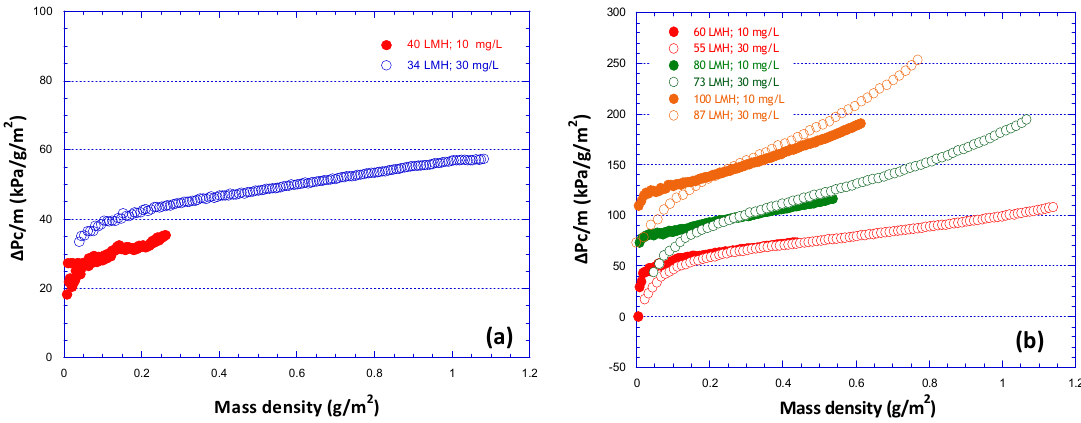
Figure 11. Variation of the quantity [ Δ P c /m] with increasing deposit-mass density, for various permeate flux values; fouling species 100% SA. Foulants concentration: 30 mg/L, this study; 10 mg/L, previous study [ 31 ]. ( a ) Flux J = 40 L/m 2 h; ( b ) J = 60–100 L/m 2 h.